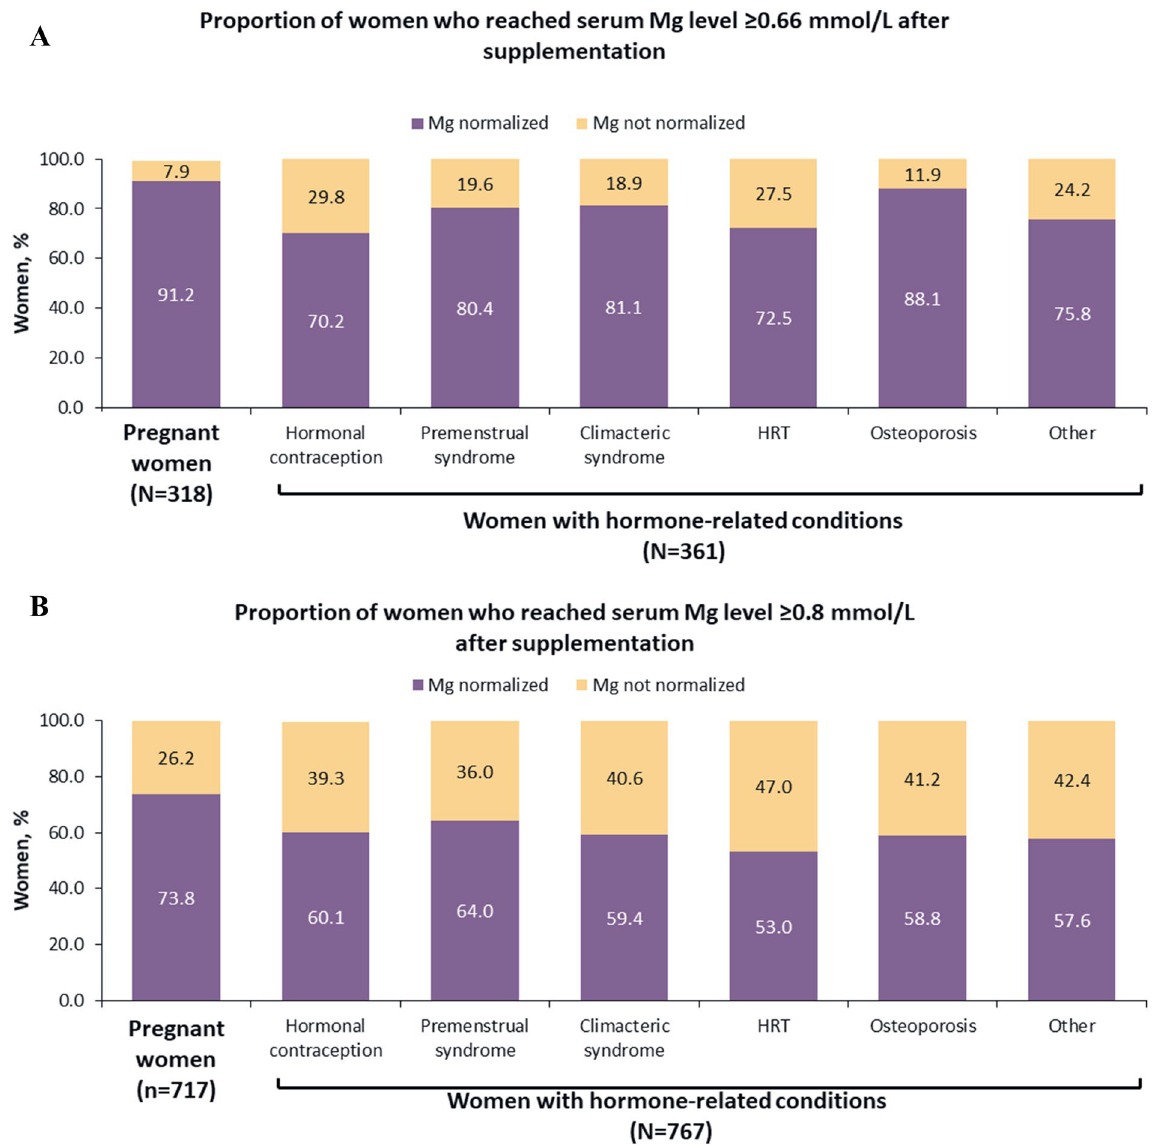
Figure 3. Proportion of women who had HME at Visit 1 and who reached target Mg serum level within 4 weeks after supplementation; HME was defined using ( A ) < 0.66 mmol/L or ( B ) < 0.8 mmol/L. Other, endometriosis; polycystic ovarian disease; uterine leiomyoma; algodismenorrhea; endometrial hyperplastic processes. HME hypomagnesemia; HRT hormone replacement therapy; Mg and women with hormone-related conditions from large (over 1 million people) and smaller cities across the Russian Federation. The generalizability of the results using such a wide geographical coverage and inclusion of varying size cities reduces the bias related to lifestyle and environmental conditions. A high prevalence of HME was noted in 79% of pregnant women and 55% of women with hormone-related conditions when using the cut-off value of < 0.8 mmol/L. The high prevalence of HME in the Russian Federation could possibly be explained by an unbalanced diet, the consumption of types of food that increase Mg require- ment (such as soft drinks containing phosphoric acid), and an overall decline in the micronutrient density of foods 22 . Calcium (Ca) and Mg levels are closely related, both vary consistently throughout the menstrual cycle and women are sensitive to these variations 7 . Additionally, specific conditions, such as pregnancy, may lead to changes in the need for Mg. Previous studies showed that serum Mg level significantly drops after 18 weeks of gestation compared with measurements before this time 23 and various studies in animal models have demon- strated that a normal gestation is associated with a higher intake of Mg 24 . Treatment of Mg deficiency with the MgB 6 combination for approximately four weeks provided a high response rate in terms of normalization of total serum Mg concentration. Pregnant women with HME had a very high response rate and serum Mg level was normalized to ≥ 0.66 mmol/L in 92.2% of women, and to ≥ 0.80 mmol/L in 73.8%. Women with hormone-related conditions showed a lower response rate